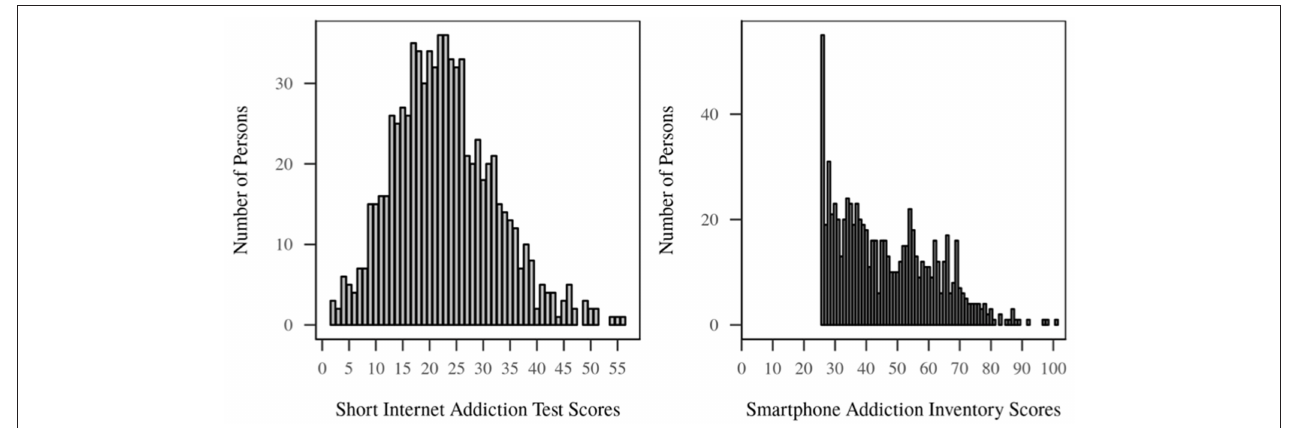
FIGURE 1 | Distribution of s-IAT and SPAI scores (N =